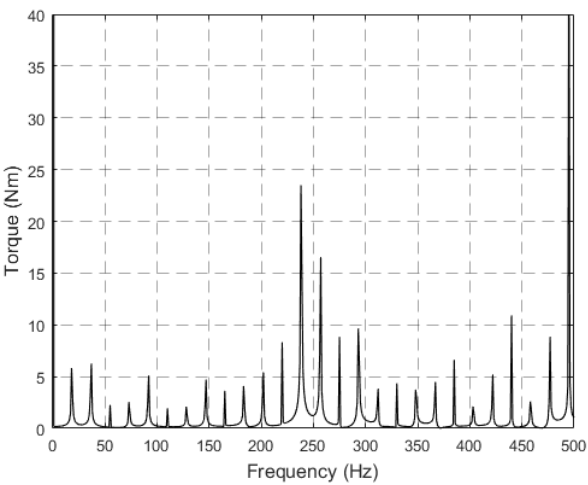
Figure 18. The torque amplitude frequency spectrum, basic DTC scheme, f ∈ [0, 500 Hz]. ω m * = 0.8 ω N .